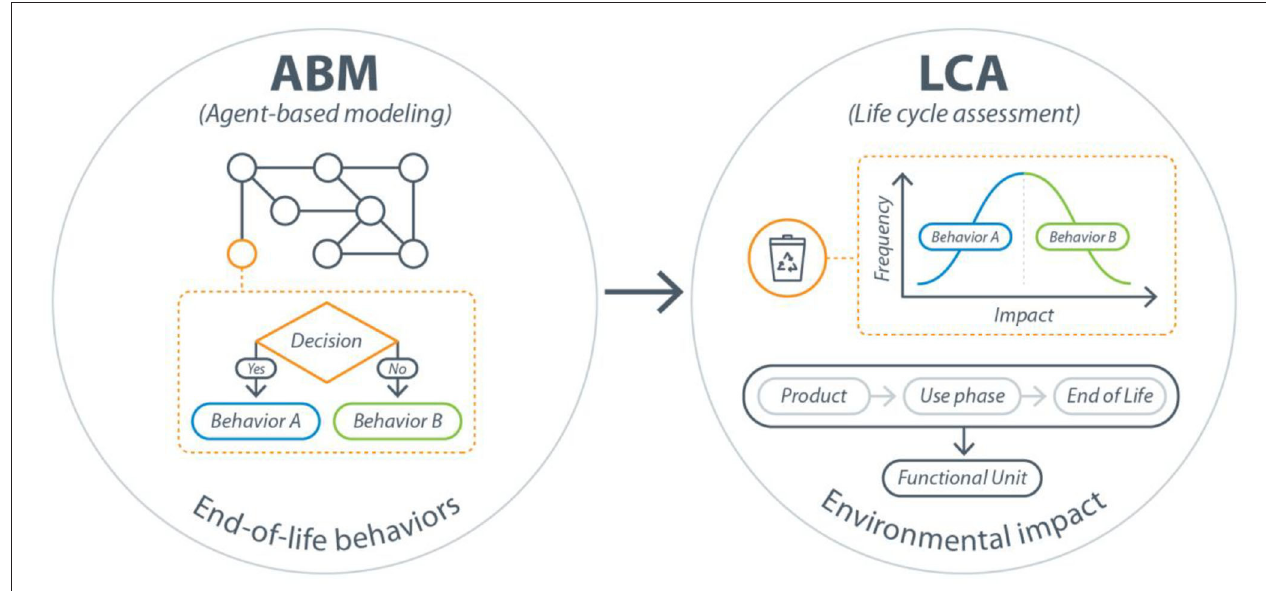
FIGURE 2 | An example of the use of combined ABM and LCA in the context of the circular economy. The ABM method could enable representing the decisions of the various actors of the CE (e.g., consumers, manufacturers, and recyclers) while LCA allows the evaluations of the environmental impacts stemming from those decisions. Typical decisions for consumers would be, for instance, to recycle a product or dump it with the regular